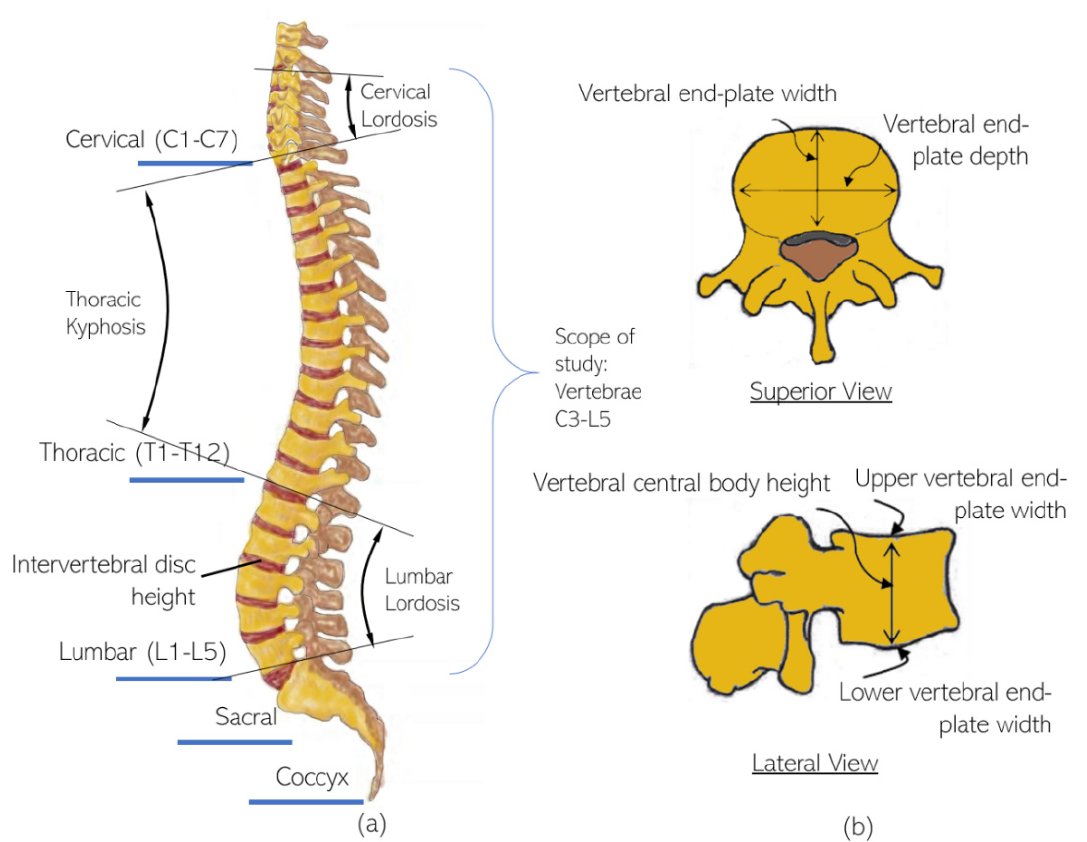
Figure 1. ( a ) Human spine anatomy (lateral view), and ( b ) typical vertebrae (superior and lateral views).